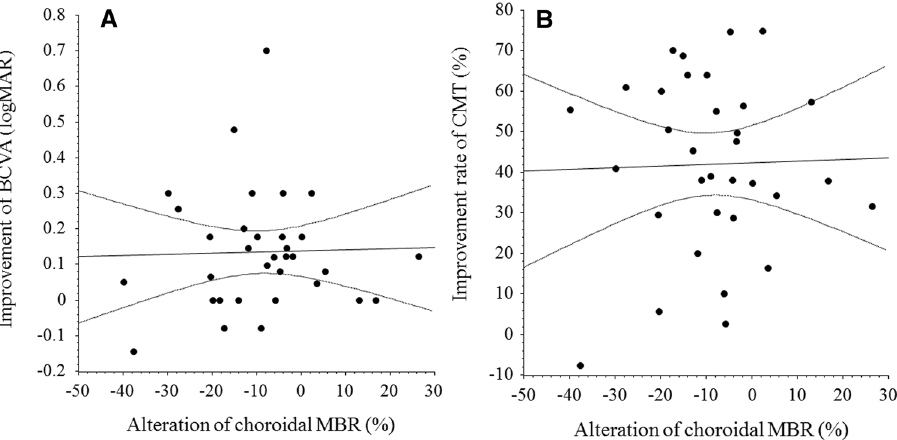
Figure 3. Correlation between change in choroidal MBR and improvement of BCVA or CMT after IRI. ( A ) There was no significant correlation between change in choroidal MBR and improvement of BCVA 1 month after IRI (ρ = 0.03, P = 0.881). ( B ) There was no significant correlation between change in choroidal MBR and improvement of CMT 1 month after IRI (ρ = 0.03, P = 0.884). BCVA, best corrected visual acuity; MBR, mean blur rate; CMT, central macular thickness; IRI, intravitreal ranibizumab